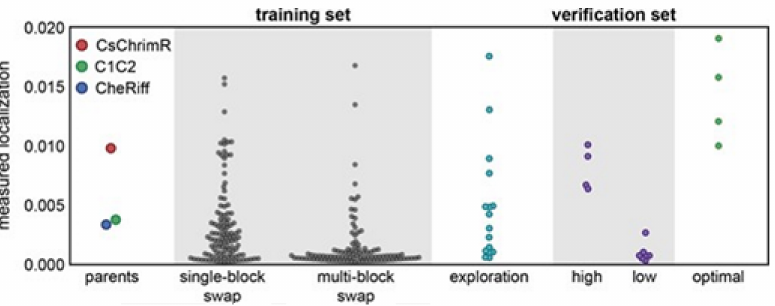
Figure 16. The comparison among all of the measured localizations in the membrane for every set of data. The swarm plots for the measurements of the localizations for each data set compared to the parents: the set of the training, the exploration, the verification, and the